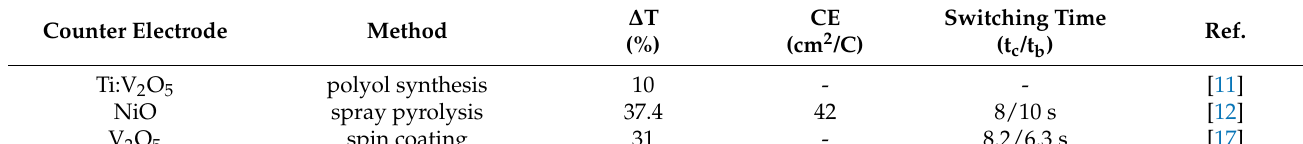
Figure 11. The CV curve comparison between buffered ECD and ECD without buffer.